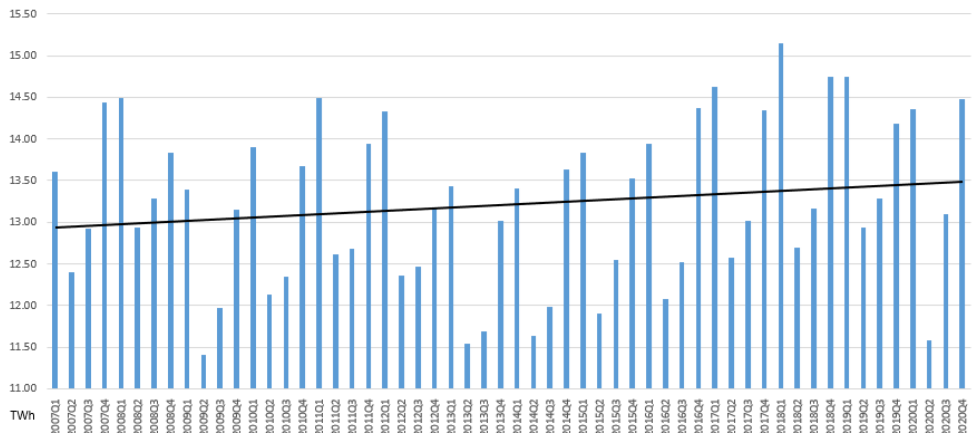
Figure 3. The evolution of electricity consumption in Romania during the period 2007–2020. During the analyzed period, the domestic electricity consumption experienced an in- significant average annual growth rate (0.02%). At the quarterly level, it is observed that in the second quarter, the rate has a negative value, due to the sharp decrease in the 2 periods of crisis (Table 1).